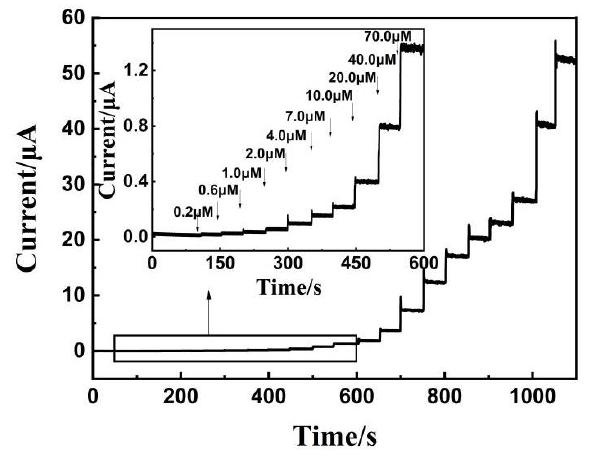
Figure 5. Typical current–time curves obtained by CoOx/C@GCE at different concentrations of nitrite